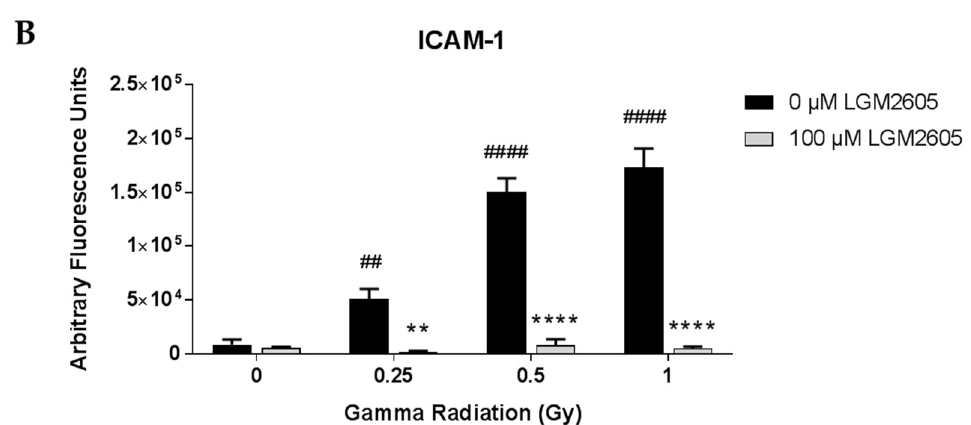
Figure 2. Evaluation of LGM2605 inhibition of intercellular cell adhesion molecule-1 (ICAM-1) expression in in vitro lung vascular networks (flow-adapted endothelial cells) exposed to gamma radiation. FAECs were exposed to 0 Gy, 0.25 Gy, 0.5 Gy, or 1 Gy gamma radiation and treated with 0 µ M or 100 µ M LGM2605 30 min following radiation exposure. Cells were harvested 24 h post radiation exposure and evaluated for ICAM-1 expression. Fluorescent images of FAECs exposed to LGM2605 (0 µ M or 100 µ M) 30 min following radiation exposure and harvested at 24 h radiation exposure and incubated with anti-ICAM-1 antibody (ThermoFisher Scientific, Waltham, MA, USA). Scale bar = 20 µ m ( A ); graphed representation of the data imaged for each condition ( B ). Data are presented as mean ± SEM. # shown in figures indicate significant differences from FAECs exposed to 0 Gy gamma radiation and treated with 0 µ M LGM2605 (## p < 0.01; #### p < 0.0001). Asterisks shown in figures indicate significant differences from FAECs exposed to 0.25 Gy, 0.5 Gy, or 1 Gy gamma radiation and treated with 0 µ M LGM2605, respectively (** p < 0.01; **** p < 0.0001).